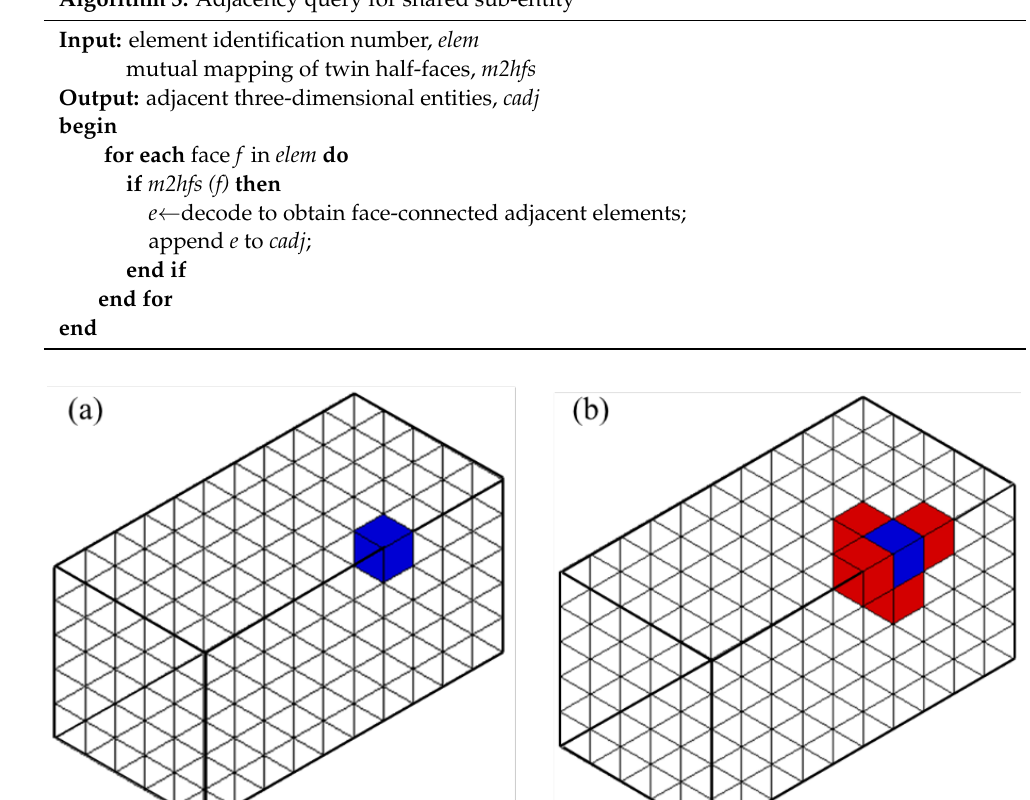
Algorithm 3: Adjacency query for shared sub-entity